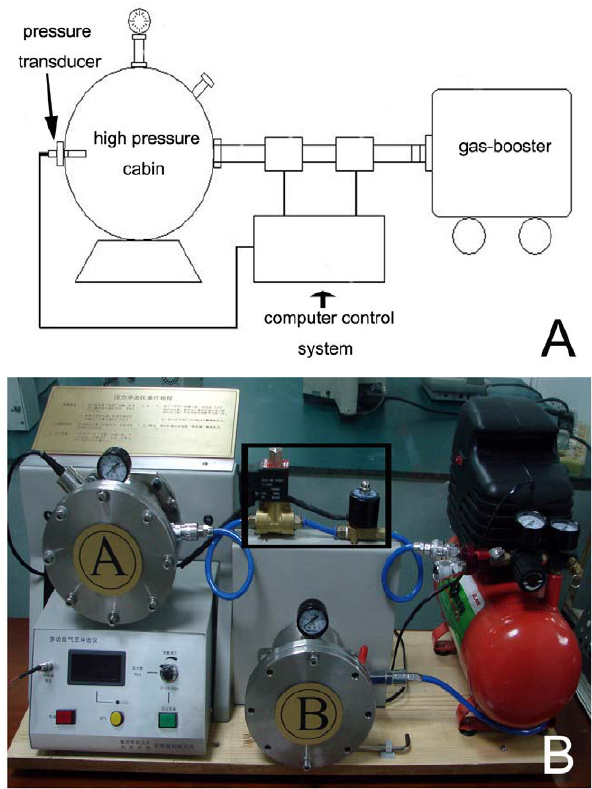
Figure 1. The device for applying pressure to cells. (A) A schematic of the custom-made instrument for applying mechanical pressure to DRG neurons. The main components of the instrument include a mechanical pressure container, a gas booster, and a pressure control system. (B) The mechanical pressure container (labeled ‘‘A’’) is connected to a gas booster (red) with a sealed tube (blue). Two metal valve tubes (in black frame) are controlled by a computer system to regulate the air